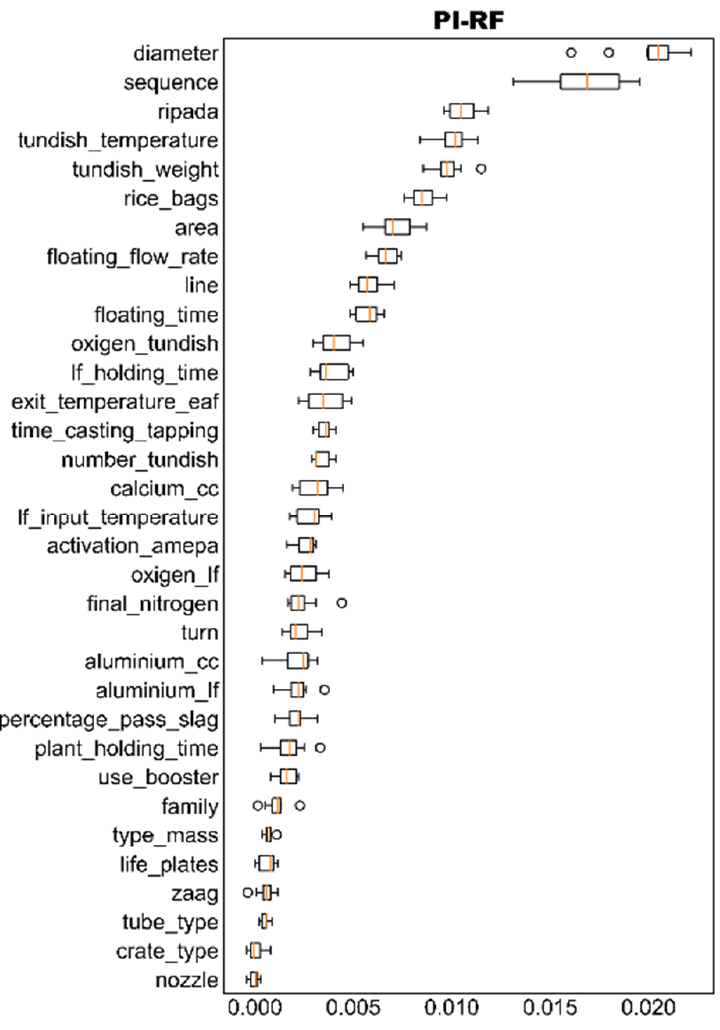
Figure 5. Boxplots showing the PI of the features through the RF optimized model.